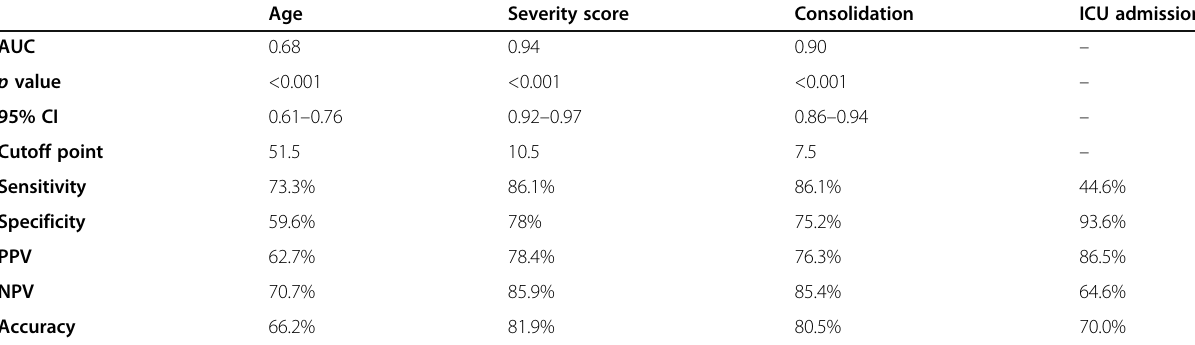
Table 5 Accuracy of independent factors for prediction of fibrosis